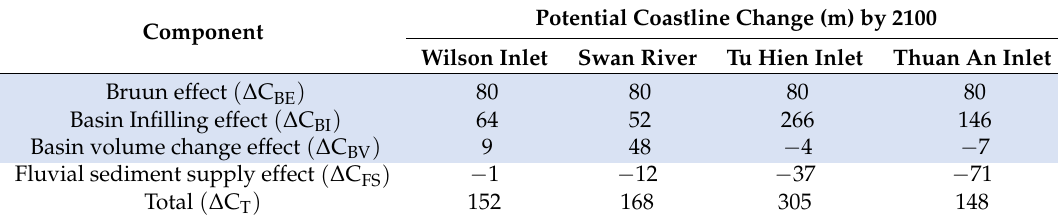
Table 3. Modelled coastline changes of the baseline case simulation.